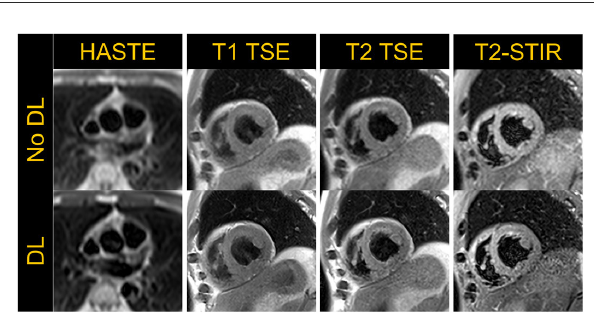
FIGURE5 Half-Fourier Acquisition Single-Shot Turbo Spin Echo (HASTE) in an axial view and T1-weighted, T2-weighted TSE and T2-short tau inversion recovery (STIR) images acquired in a mid-short axis view in a volunteer demonstrate the application of dark-blood turbo spin echo based cardiac imaging techniques. The top row shows images without deep-learning (DL) based image enhancement while the bottom row depicts images with increased sharpness resulting from DL-based image reconstruction.